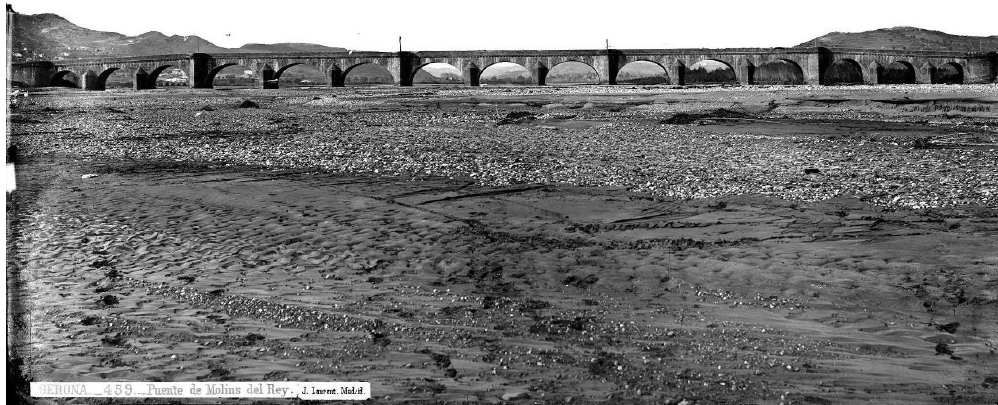
Figure 10. Bridge close to town D, shot by well-known French photographer Jean Laurent probably in 1866–1867. The only bridge in lower Llobregat at that time had a total length of 334.36m, with 15 arches, the central nine of which spanned 19.22m each. It failed in 1971. Note the extremely wide alluvial area full of sand and